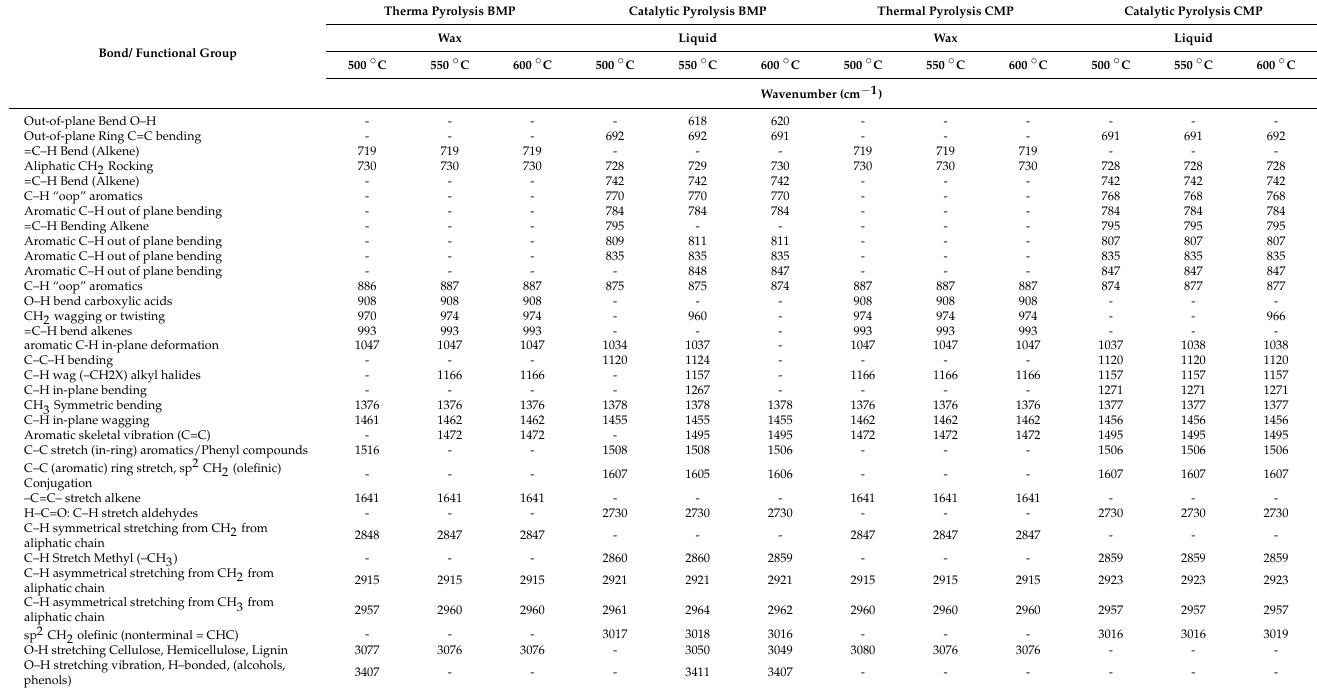
Table 9. FTIR spectra band assignments for products of thermal and catalytic pyrolysis in